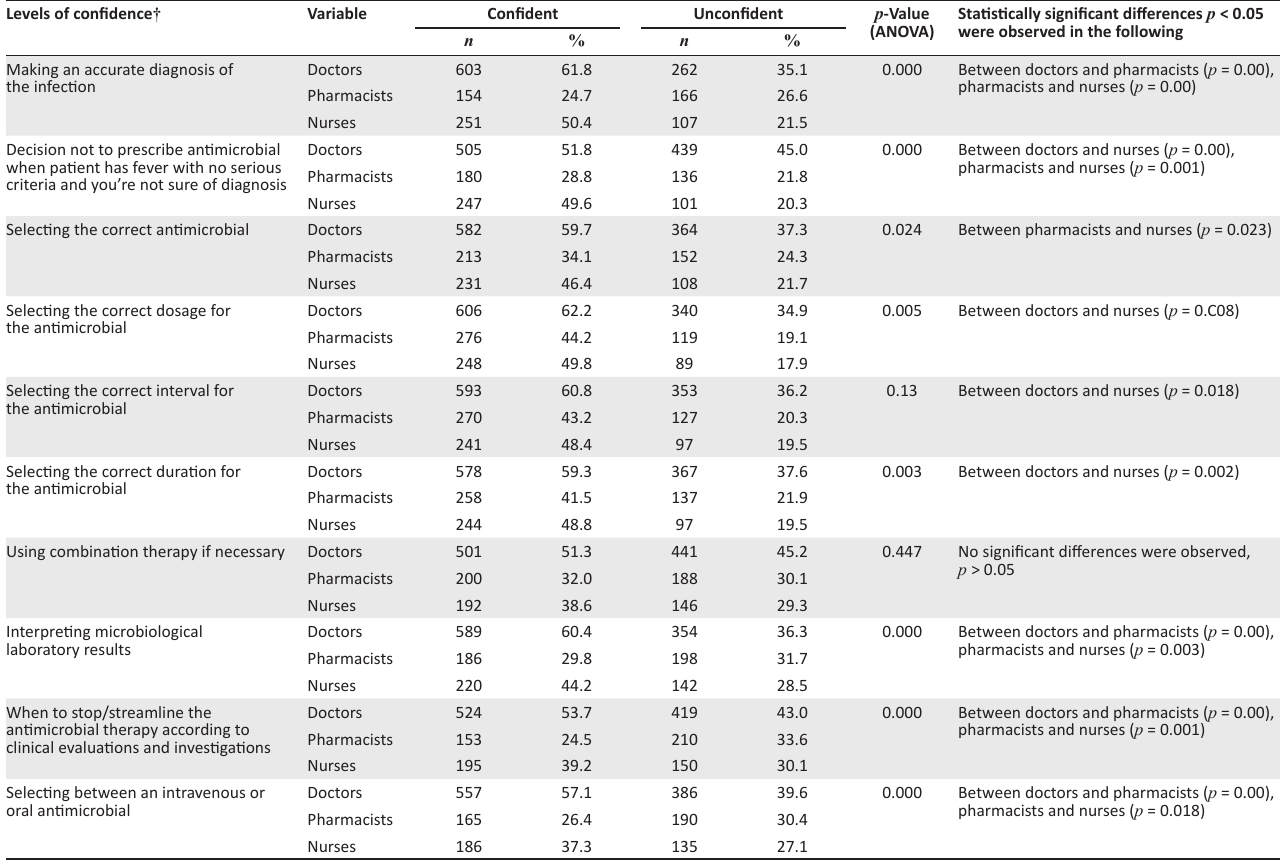
FIG URE 2: Selection of contributory factors resulting in antimicrobial resistance. TABLE 2: Self-assessment on confidence in various aspects of prescribing antimicrobials. Levels of confidence